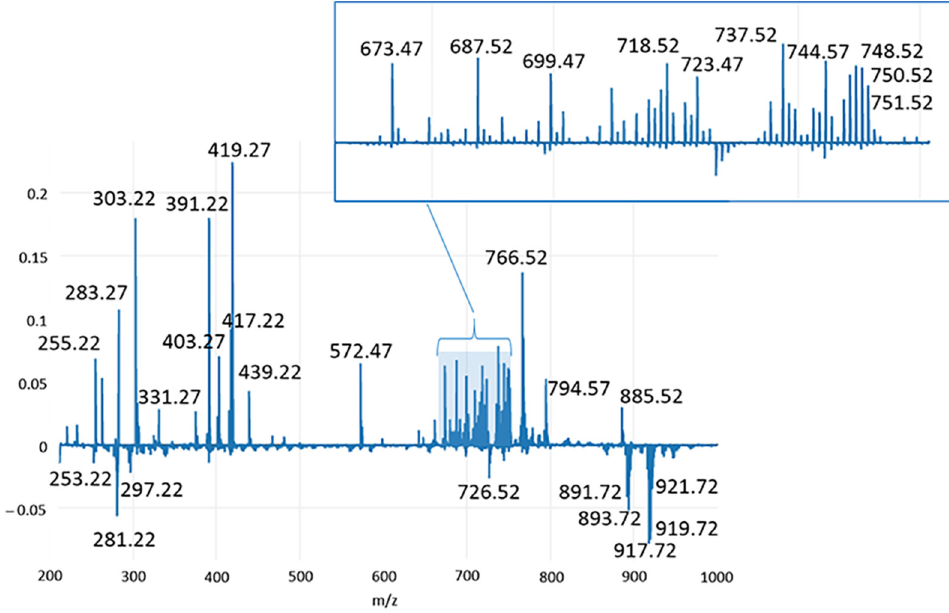
Figure 5. Loading plot relative to the PC1 component, explaining the 30.02% of the total variance of the model.